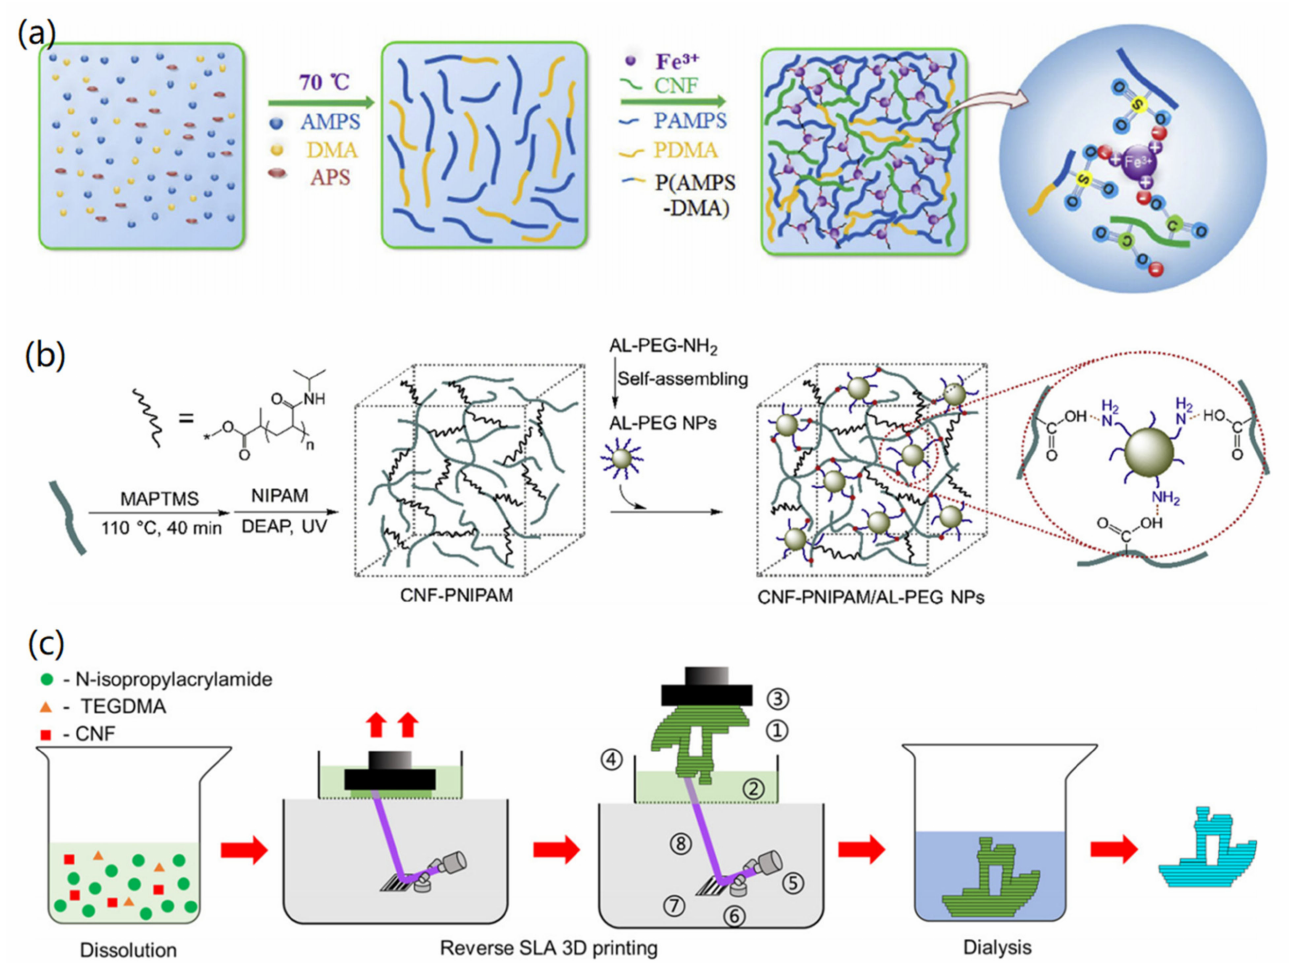
Figure 3. Fabrication of CNF-based hydrogels: ( a ) Fe 3+ -mediated crosslinking and CNF hydrogel formation. Reprinted with permission from Ref. [49], Copyright 2019, Elsevier Ltd. ( b ) Polymer-mediated self-assembling and CNF hydrogel formation. Reprinted with permission from Ref. [51], Copyright 2019, Elsevier Ltd. ( c ) 3D printed PNIPAm/CNF hydrogels. Reprinted with permission from Ref. [52], Copyright 2020, Elsevier